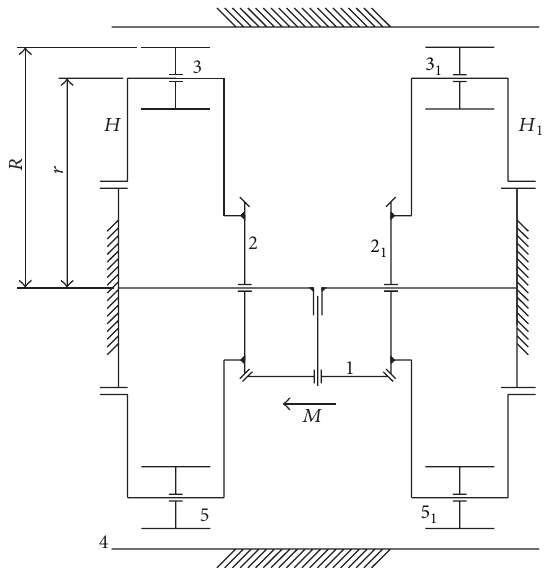
Figure 1: The model of processing module gear drive